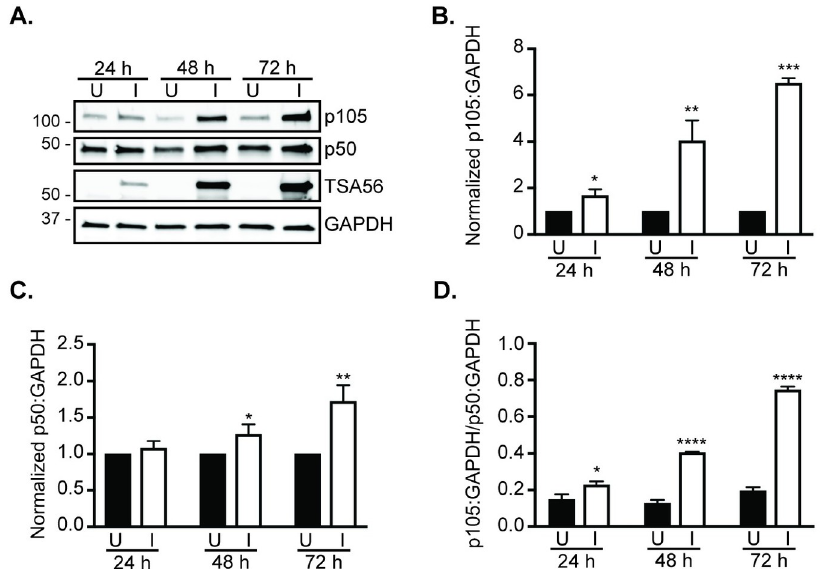
Fig 1. p105 levels are increased in O . tsutsugamushi infected HeLa cells under resting state conditions. (A) Whole cell lysates of O . tsutsugamushi infected (I) and mock infected (U) HeLa cells recovered at 24, 48, and 72 h post- infection were subjected to Western blot analyses using antibodies specific for p105, p50, O . tsutsugamushi TSA56, and GAPDH. Data are representative of three separate experiments. (B to D) Mean normalized ratios + SD of p105: GAPDH (B), p50:GAPDH (C), and p105:GAPDH/p50:GAPDH (D) at the indicated time point(s) from three independent experiments were calculated using densitometry. Statistically significant ( � , P < 0.05; �� , P < 0.01; ��� , P < 0.001; ���� , P < 0.0001) values are